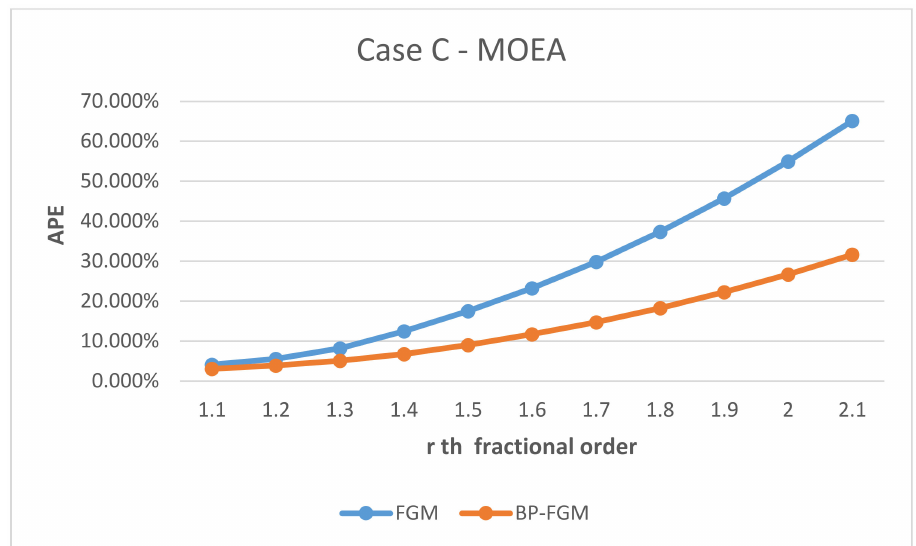
Figure 9. Representing the absolute percentage error for Case C by using the FGM and BP-FGM